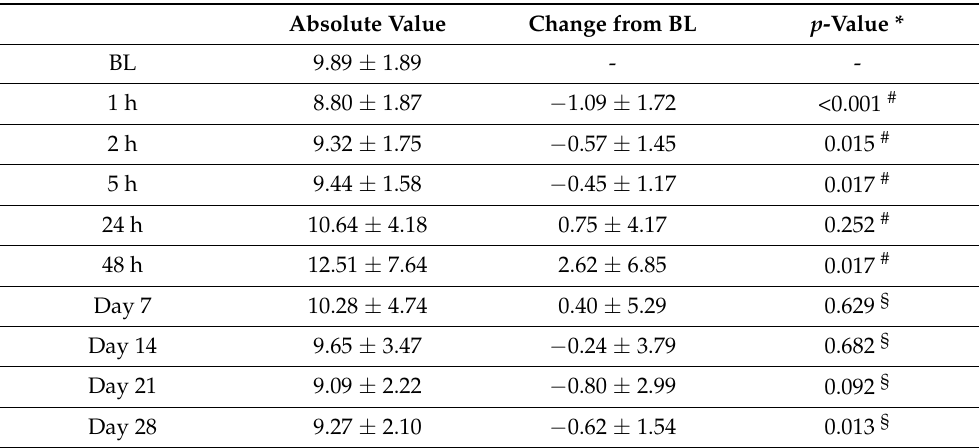
Table 5. Absolute TEWL measurement values and changes from baseline after single application of Emollient 2 (first 48 h) followed by once-daily application for 26 days. Absolute Value